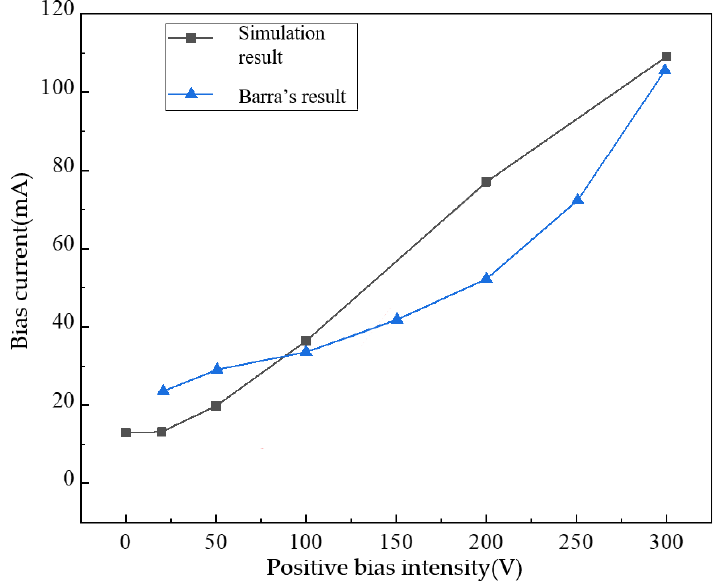
Figure 3. Variation of bias current with bias intensity.